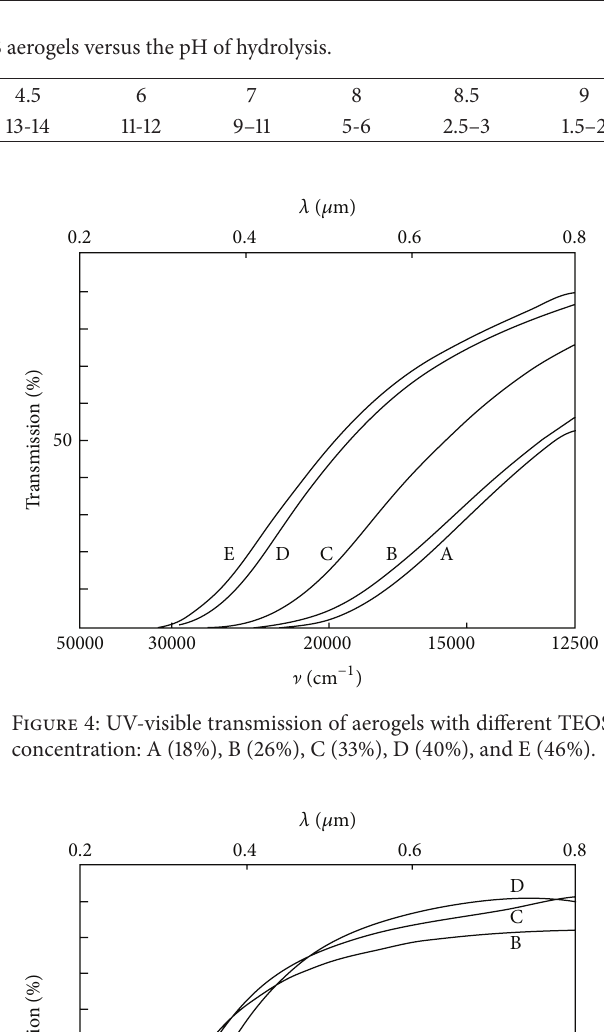
lightest aerogels contain a greater proportion of large pores (scatters) which make them less translucent